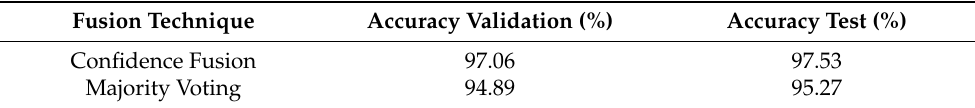
Table 10. Results of trimodal prediction of trust using top 2 performing models.